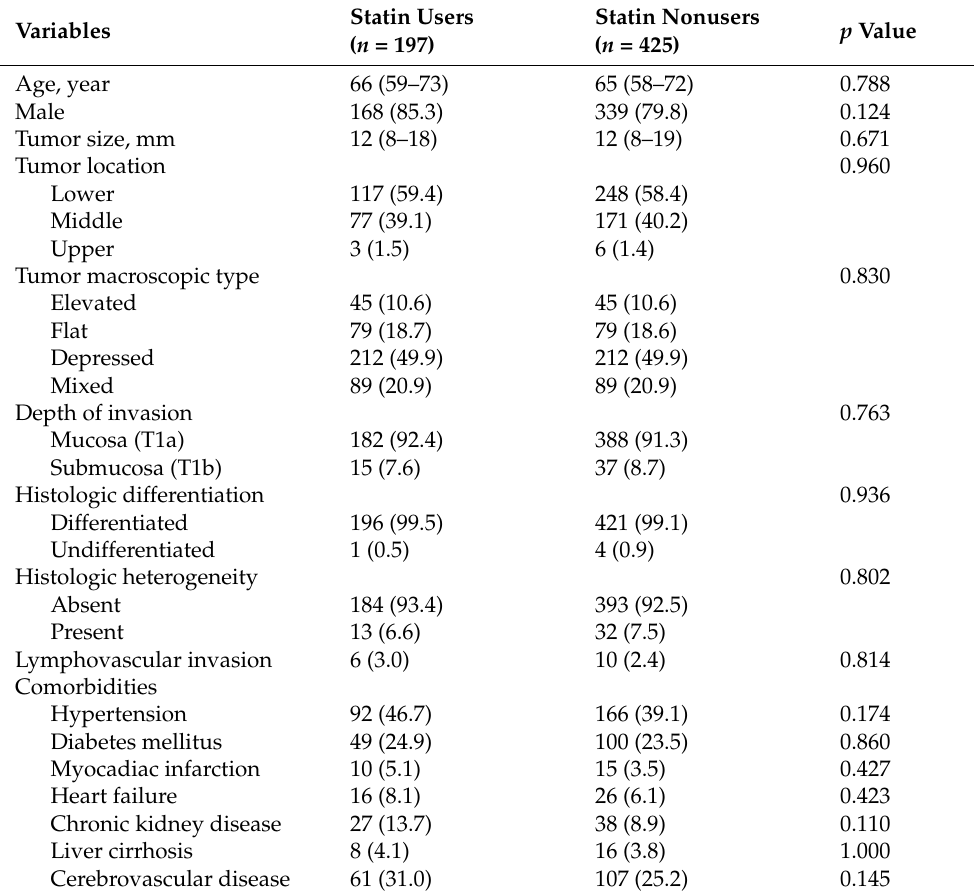
Table 5. Baseline characteristics of the propensity score-matched cohort